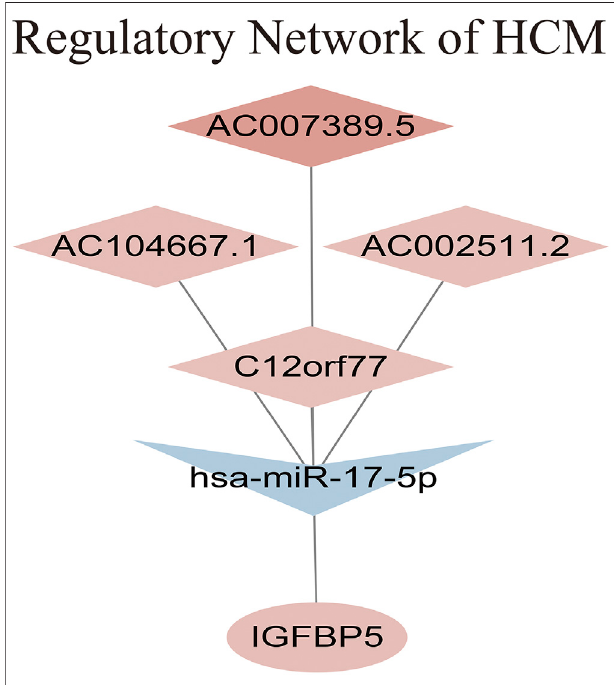
FIGURE 6 | Regulatory network of